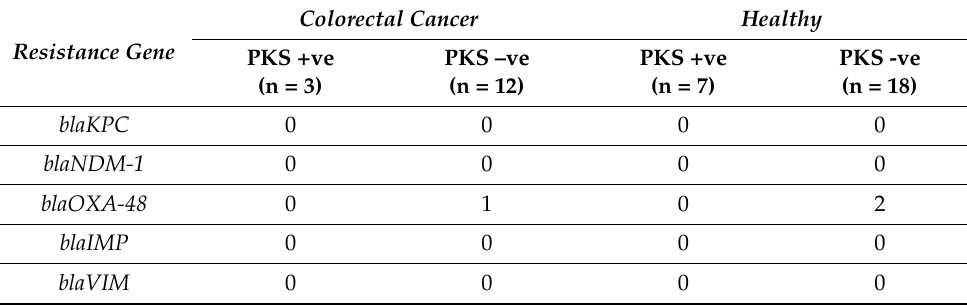
Table 5. Presence of carbapenem-resistance genes among K. pneumoniae